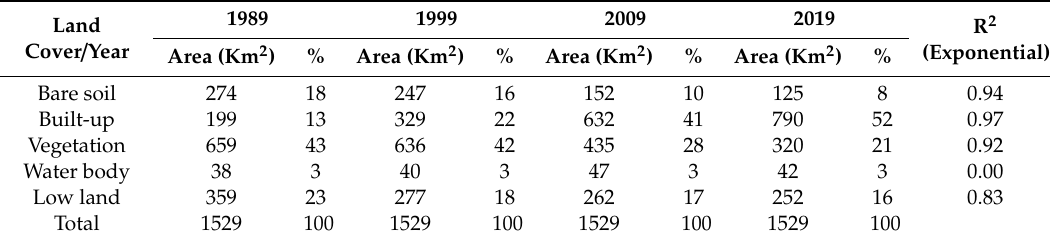
Table 4. Aerial statistics of classified images for the DMDP area.